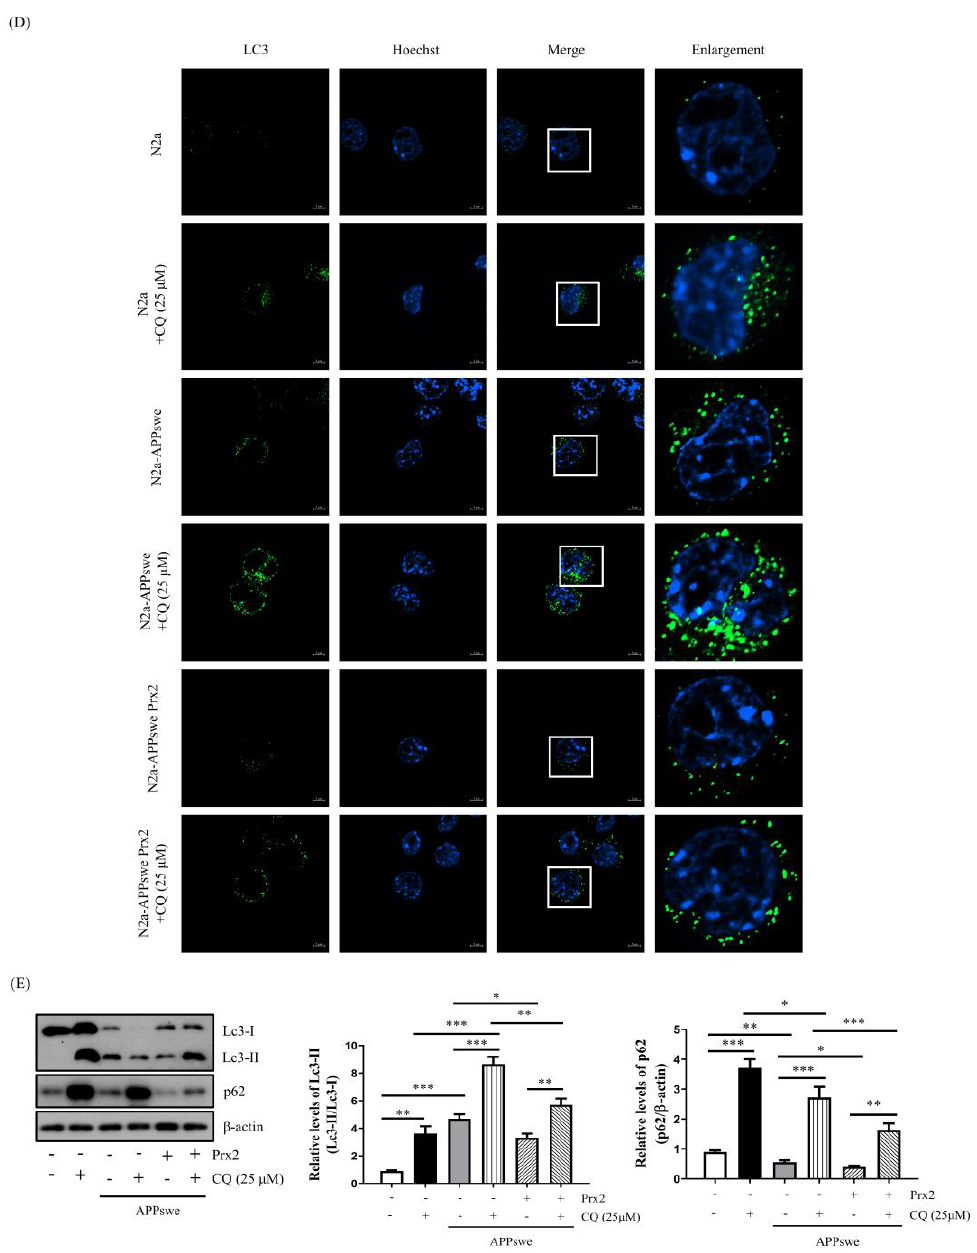
Figure 4. Peroxiredoxin (Prx) 2 overexpression decreased the levels of ROS and autophagy in N2a-APPswe cells. ( A ) The expression of Prx2 and –v5 was confirmed by Western blot analysis in N2a, N2a-APPswe, and N2a-APPswe-Prx2 cells cultured for 24 h. ( B ) Flow cytometry analysis of the intracellular ROS levels in N2a, N2a-APPswe, and N2a-APPswe-Prx2 cells cultured for 24 h. ( C ) ATG5, ATG7, Beclin-1, Lc3, and p62 protein expression levels were analyzed by Western blot analysis in N2a, N2a-APPswe, and N2a-APPswe-Prx2 cells cultured for 24 h. ( D ) Confocal microscopy analysis of Lc3 puncta in N2a, N2a-APPswe, and N2a-APPswe-Prx2 cells cultured for 24 h with or without CQ (25 µ M). ( E ) Lc3 and p62 protein expression levels were determined by Western blot analysis in N2a, N2a-APPswe, and N2a-APPswe-Prx2 cells cultured for 24 h with or without CQ (25 µ M). Data are represented as the means ± SEMs of three independent experiments (* p < 0.05, ** p < 0.01, and *** p < 0.001).